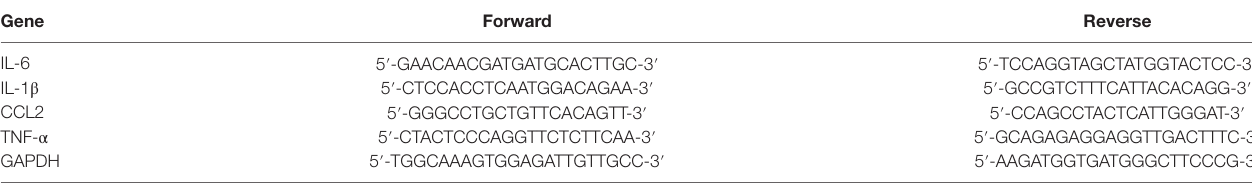
TaBlE 2 | List of primers